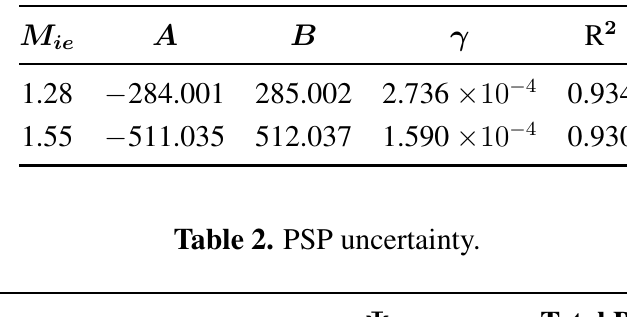
Table 1. PSP calibration constants.